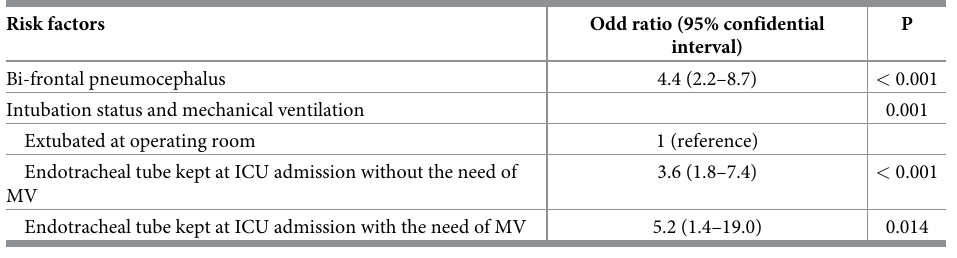
Table 5. Independent risk factors for postoperative agitation.